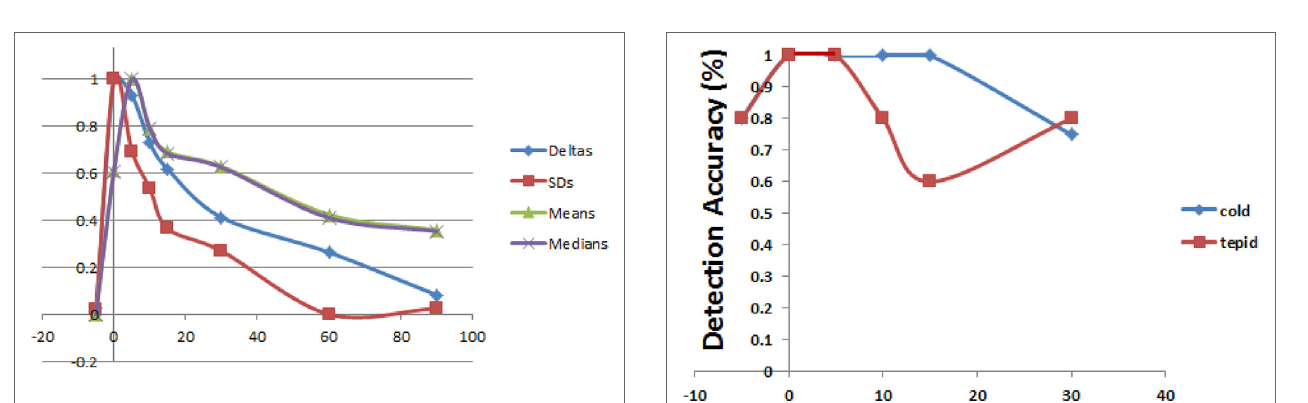
FigUre 13 | Comparison of features over time while drinking water.